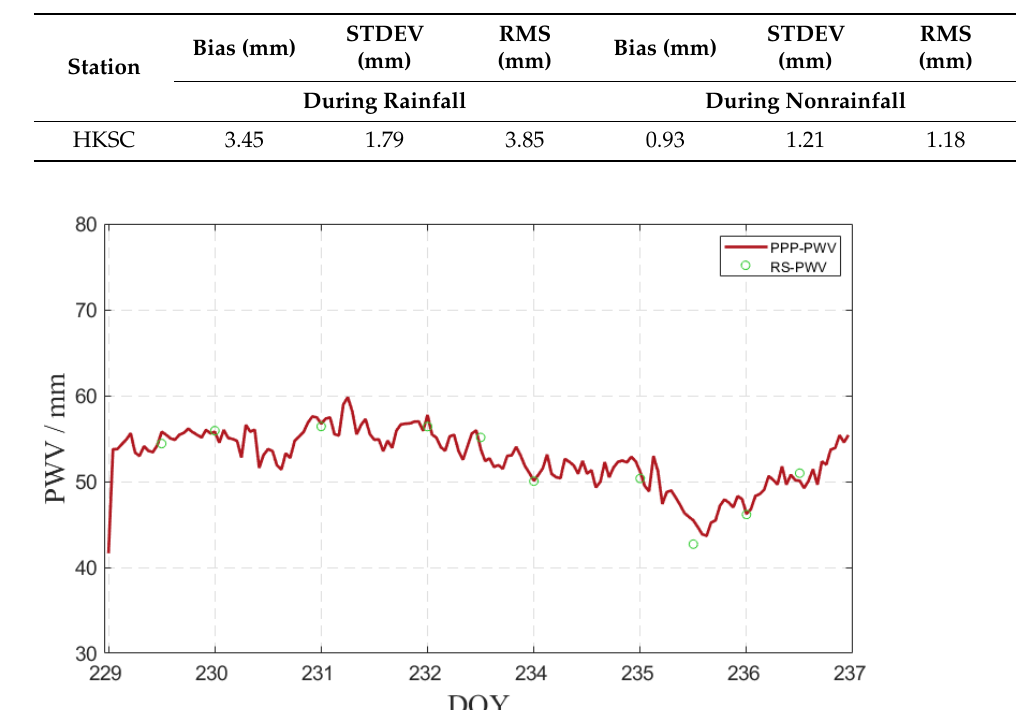
Figure 5. Comparison of PPP PWV between HKSC station and radiosonde station during nonrain- fall.